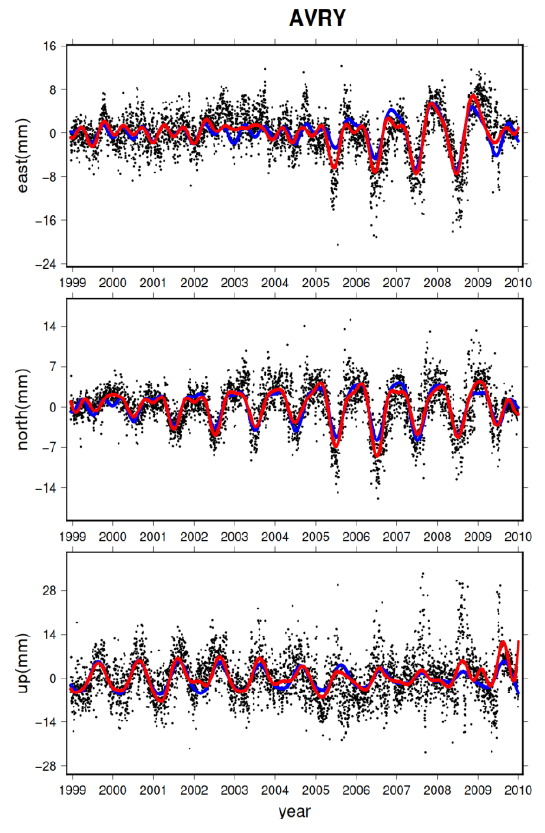
Figure 1 . GPS stations map